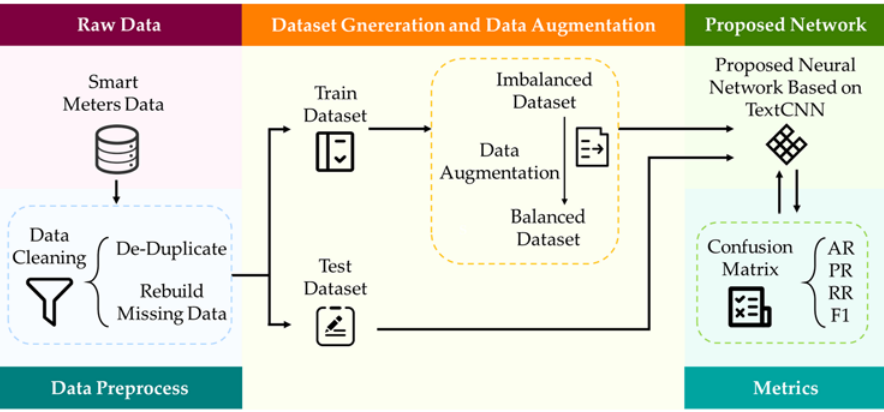
Figure 5. Proposed electricity detection scheme.